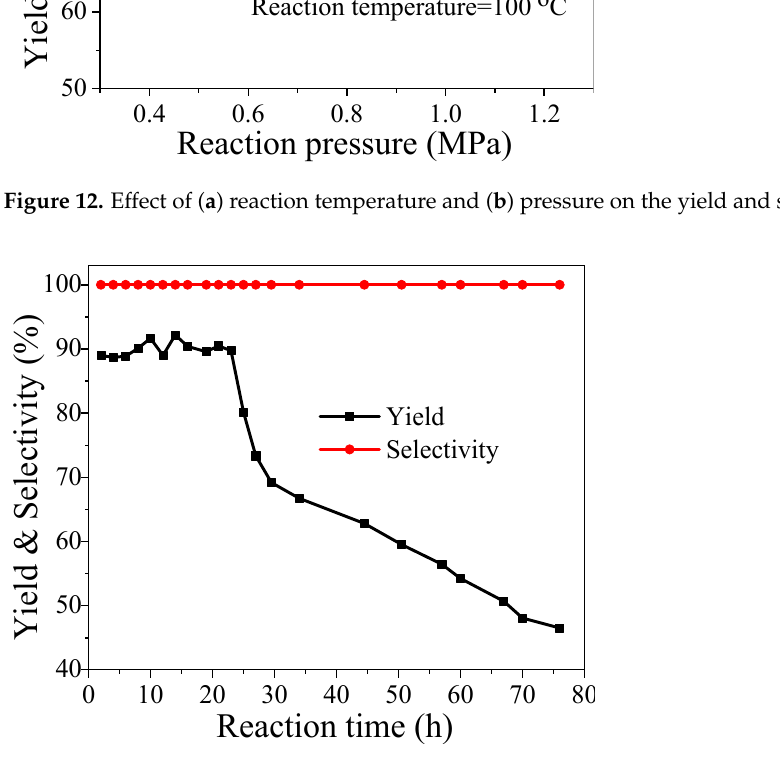
Figure 13. Catalytic stability test for Ni 10 Mo 10 Al catalyst at the reaction conditions of 100 ◦ C, 1 MPa H 2 , n(H 2 )/n(MA) = 4 and WHSV = 2 h − 1 .